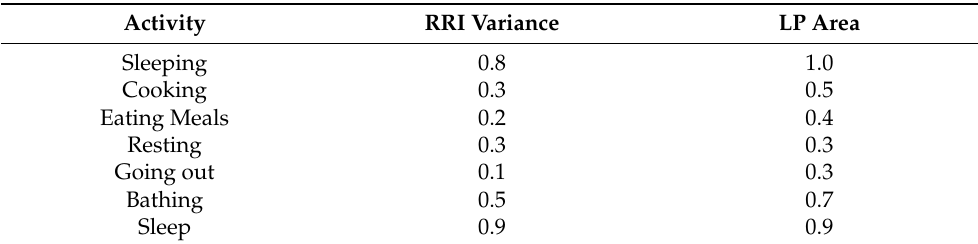
Table 2. Per-activity stress